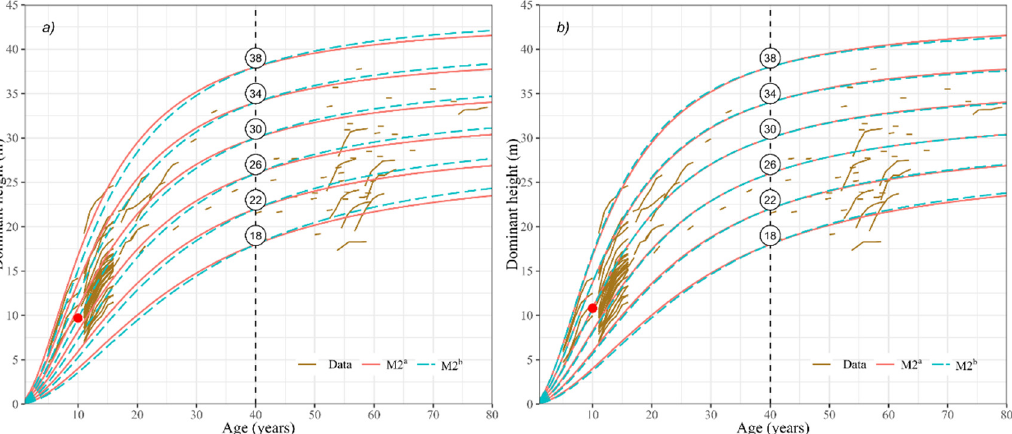
Figure 4. Site index curves for the stands of patula pine with equation M2 a and M2 b at a base-age